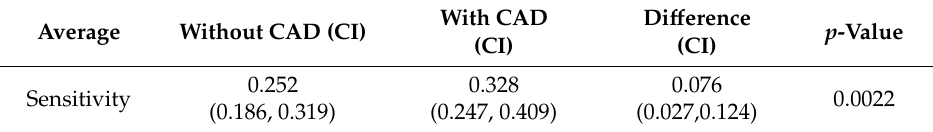
Table 9. The average sensitivity at a specificity = 0.95 for all readers. Average Without CAD (CI)